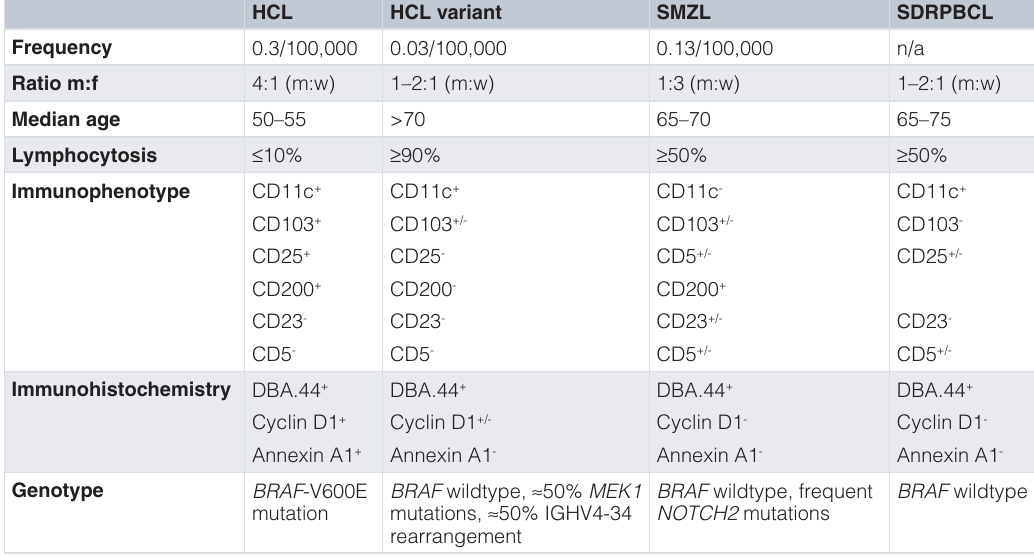
Table 1. Differential diagnoses in HCL and their characteristic features.